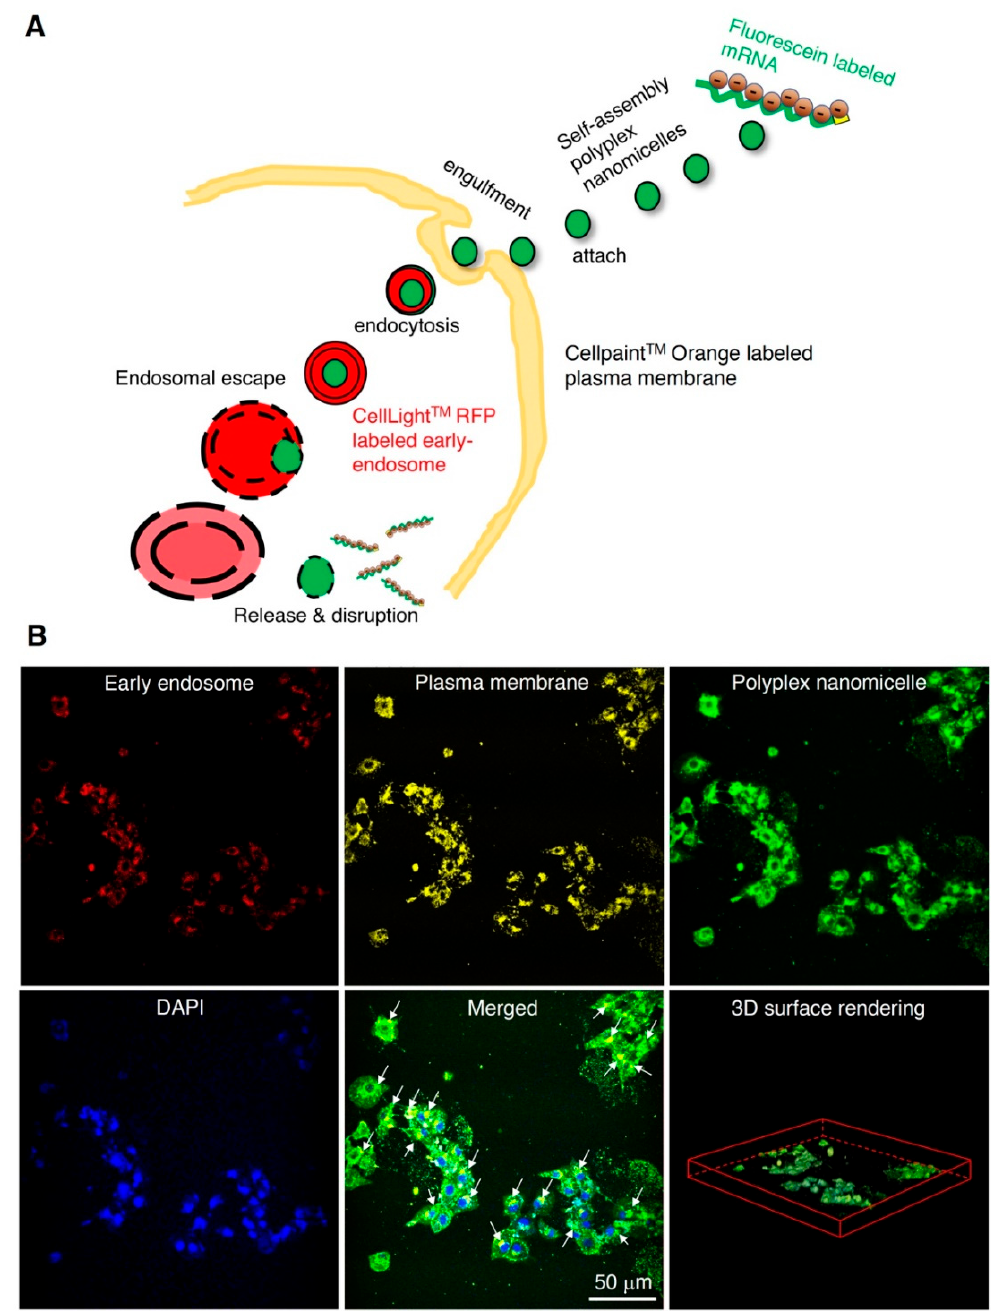
Figure 2. Endocytosis of Luc2 mRNA-loaded polyplex nanomicelles examined by 2-photon microscopy. ( A ) The proposed self-assembly polyplex nanomicelle delivers the mRNA medicine into cells via endocytosis. Fluorescent dyes labeled the mRNA, early endosome, and cytosol for 2-photon imaging. ( B ) Luc2 mRNA labeled with fluorescein for self-assembly polyplex nanomicelle preparation, early endosomes labeled with a red fluorescent protein, plasma membrane labeled with an orange fluorescent dye, and the nucleus labeled with DAPI for 2-photon imaging. Images were captured at 20 min after polyplex nanomicelle administration in a BMSCs culture medium and processed with ImageJ/Fiji software. Representative images are shown, and white arrows indicate the widespread polyplex nanomicelles merged with early endosomes.